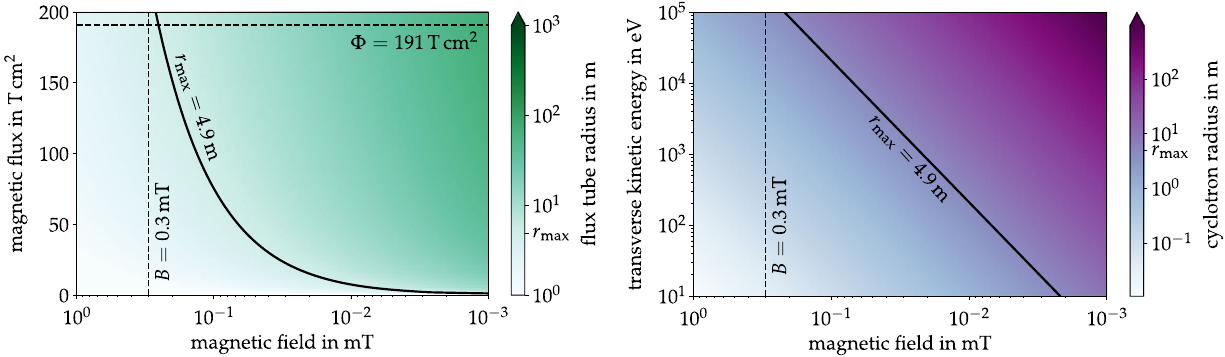
Fig. 3 Effects of the magnetic pulse on stored electrons. The magnetic field decreases towards the right in both plots; the dashed vertical lines markthenominalfieldintheanalyzingplane( B min = 0 . 3 mT).Left:the fluxtubewidenswhenthemagneticfielddecreasesaccordingtoEq.(5). In this plot the magnetic flux corresponds to a flux tube cross-section with radius r flux in the spectrometer center (indicated by color), and the solid line indicates the maximal vessel radius r max = 4 . 9 m. Electrons stored in a flux tube region with r flux > r max are removed, and electrons